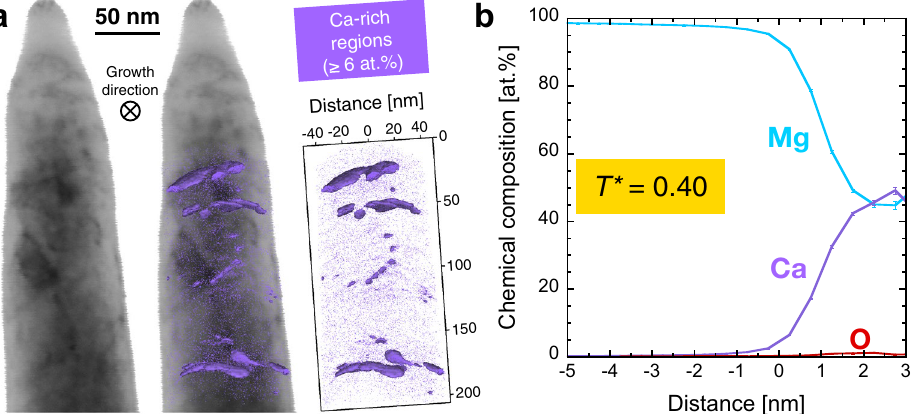
Figure 5. Correlative microstructural and compositional characterisation of the (Mg,Ca) solid solution thin film grown at T* = 0.40, combining scanning transmission electron microscopy and atom probe tomography. ( a ) Bright field image of an atom probe specimen, reconstruction of calcium atomic positions with highlighted calcium-rich regions (≥ 6 at%) as well as an overlay of the bright field image and the atom probe reconstruction. ( b ) Proximity histogram which reveals the evolution of chemical composition from the grains into the grain boundaries. 0 nm distance corresponds to the threshold composition of 6 at% calcium as indicated in ( a ). The corresponding mass spectrum and applied ranging as well as atomic positions of Mg, Ca, O and Mg 2 O can be found in Fig. SI5, Table SI2 and Fig. SI4, respectively. Figure ( a ) was created with IVAS 3.8.0 (https:// www. atomp robe. com) and Fig. ( b ) was created with KaleidaGraph 4.5.3 (https:// www. syner gy.